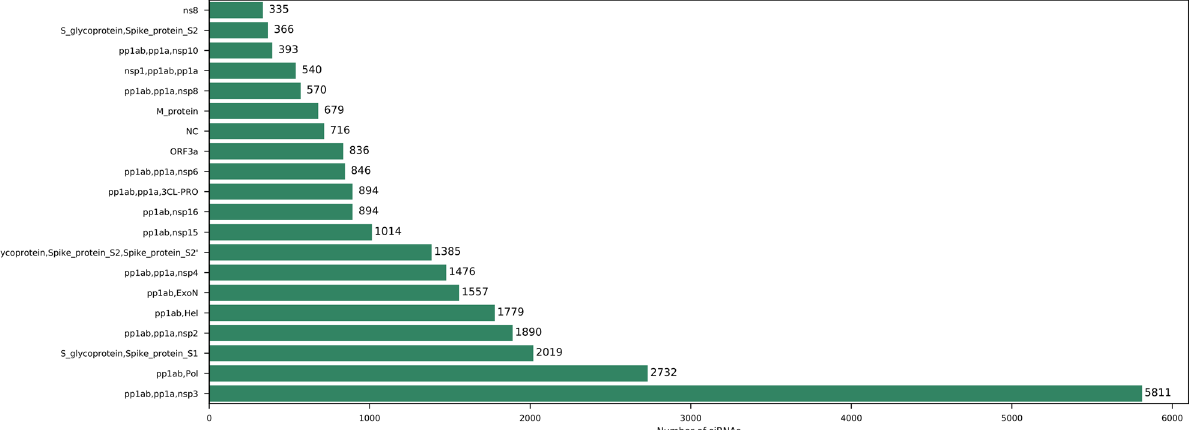
Figure 1. Distribution of 21nt siRNAs across the twenty more 21nt-siRNA-abundant genes from SARS-CoV-2. Number of siRNA targets per gene, displayed in horizontal bars. Overlapping genes are displayed at the same line, separated by comma.